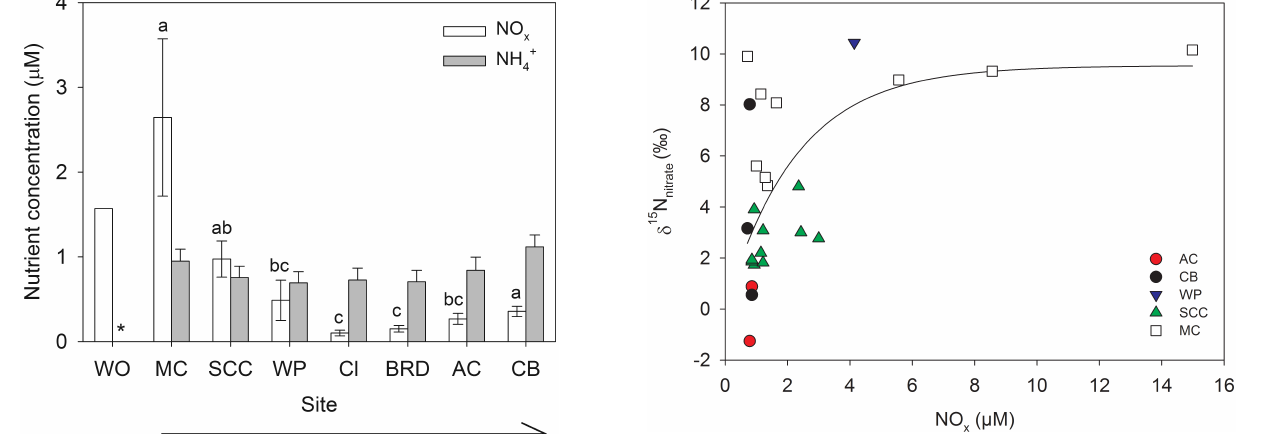
Nitrate δ 18 O was not significantly different between sites ( F 4 , 25 = 0 .